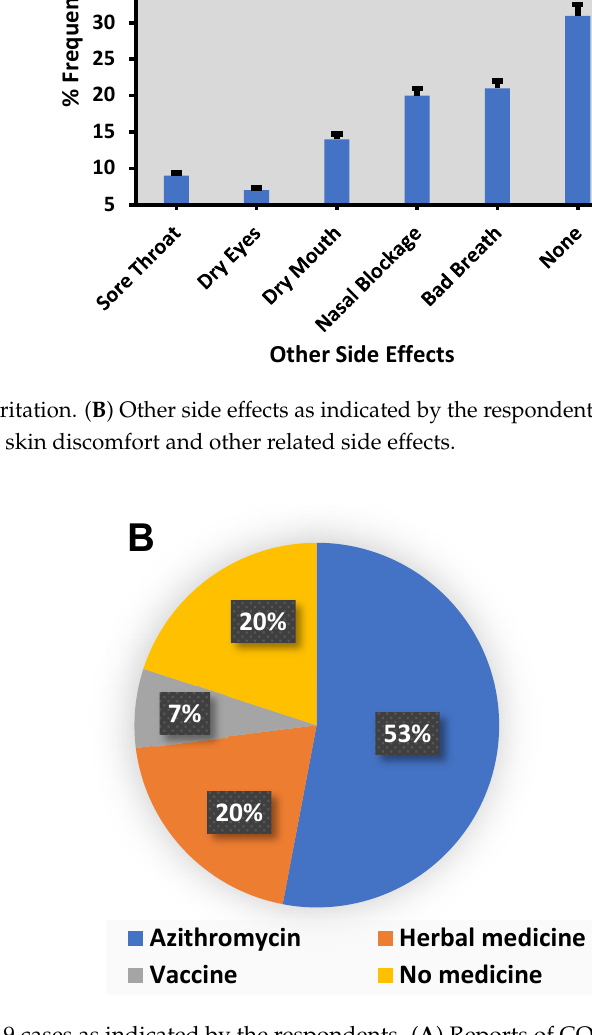
Figure 4. Incidence of COVID-19 cases as indicated by the respondents. ( A ) Reports of COVID-19 infection. ( B ) Treatments received for COVID-19 infection. Error bars represent the percentage of COVID-19 cases.